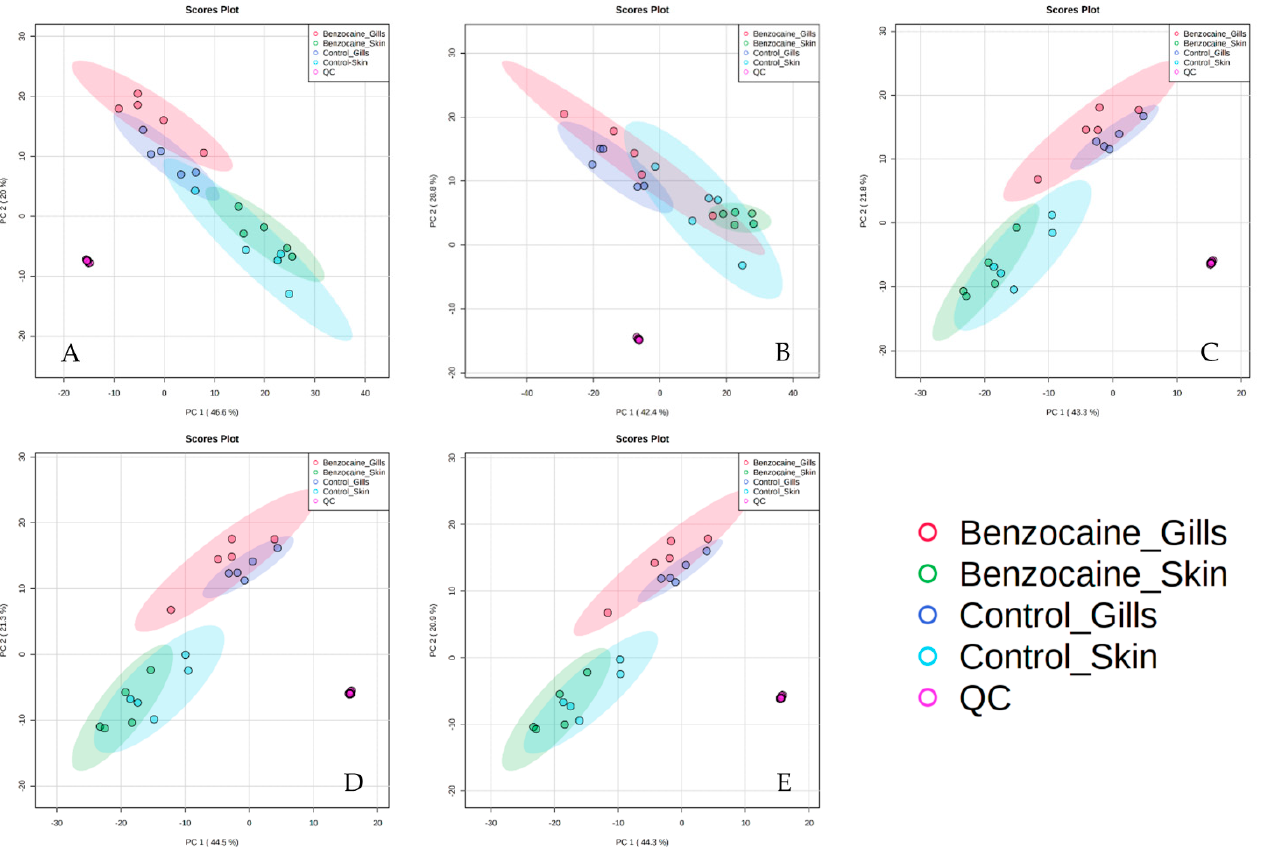
Figure 1. Two-dimensional score plots from PCA of the raw data ( A ) and data normalized by total protein content ( B ), sum ( C ), median ( D ) and median fold change ( E ). The different groups correspond to skin and gill mucus samples collected following percussive stunning (“Control_Skin” and “Control_Gills”) or benzocaine overdosing (“Benzocaine_Skin” and